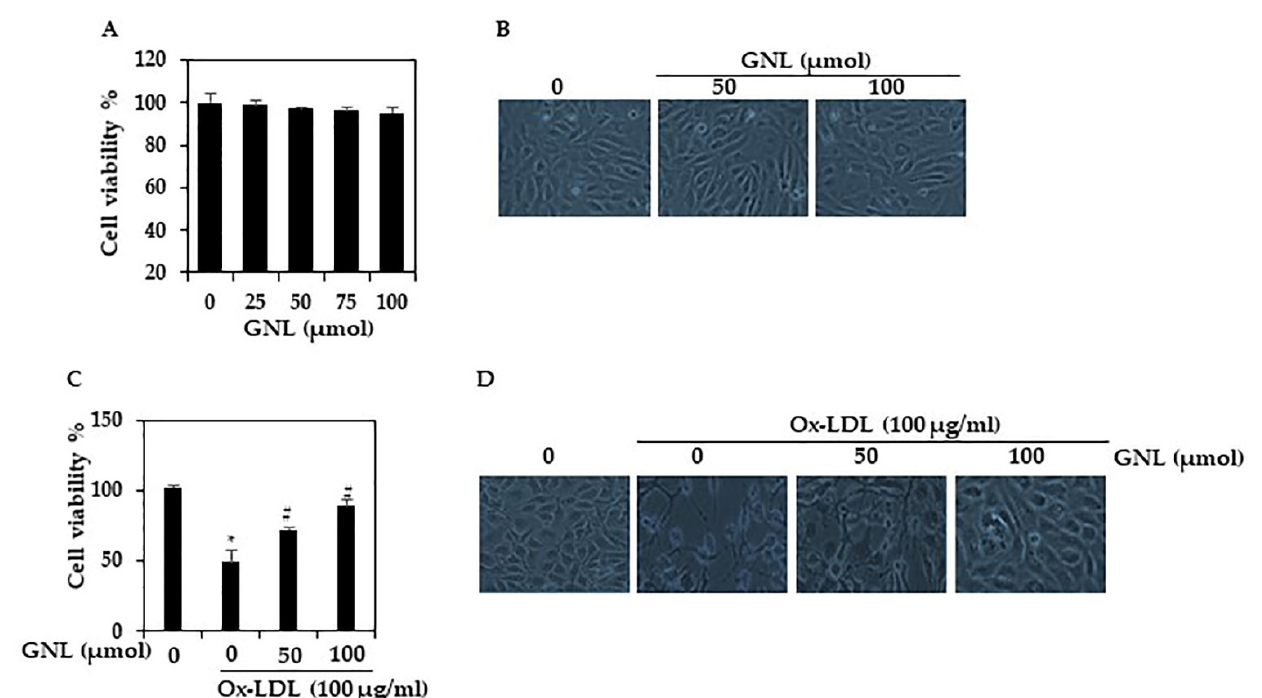
Figure 2. GNL chemical structure, its effects on Ox-LDL-induced cell viability, and the morphological changes. ( A ) HUVECs were added with GNL for 24 h and viability was measured by MTT. ( B ) GNL effect on the morphology of HUVECs. ( C ) In an MTT assay, GNL prevents Ox-LDL’s cytotoxicity (24 h). There are three replicates of each value, and * p < 0.05 represents a significant difference when compared to the control group. The # p < 0.05 represents significant differences between Ox-LDL alone and GNL with Ox-LDL treatment groups. ( D ) In Ox-LDL-induced HUVECs, GNL protects cell morphology.